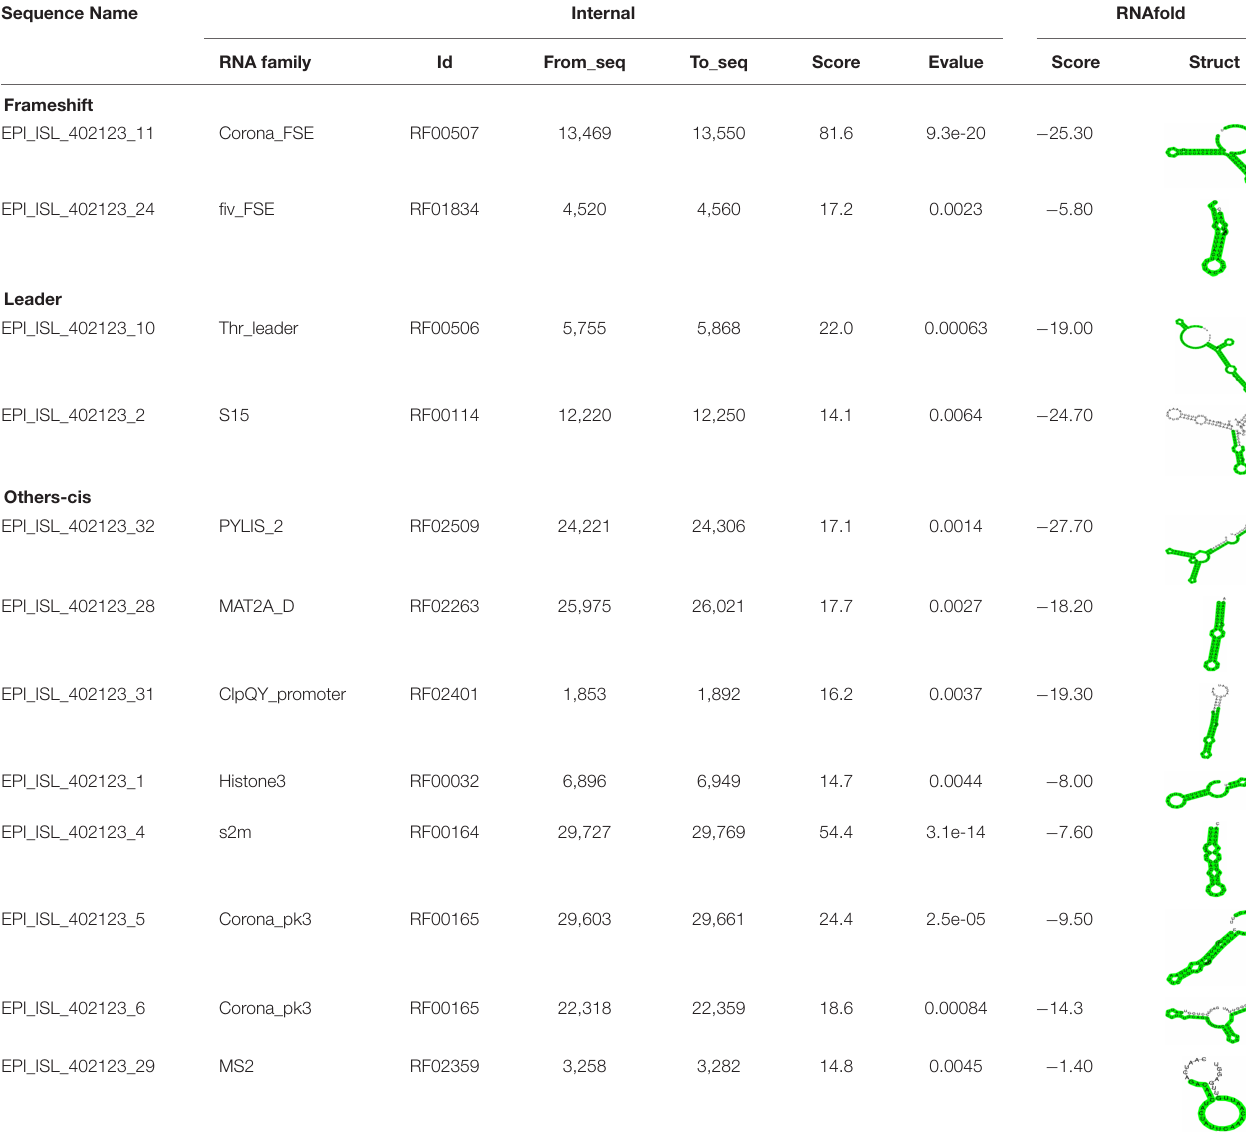
TABLE 2 | Different classes of cis -acting RNA elements and RNA family motifs on SARS-CoV-2 RNA (Accession Number